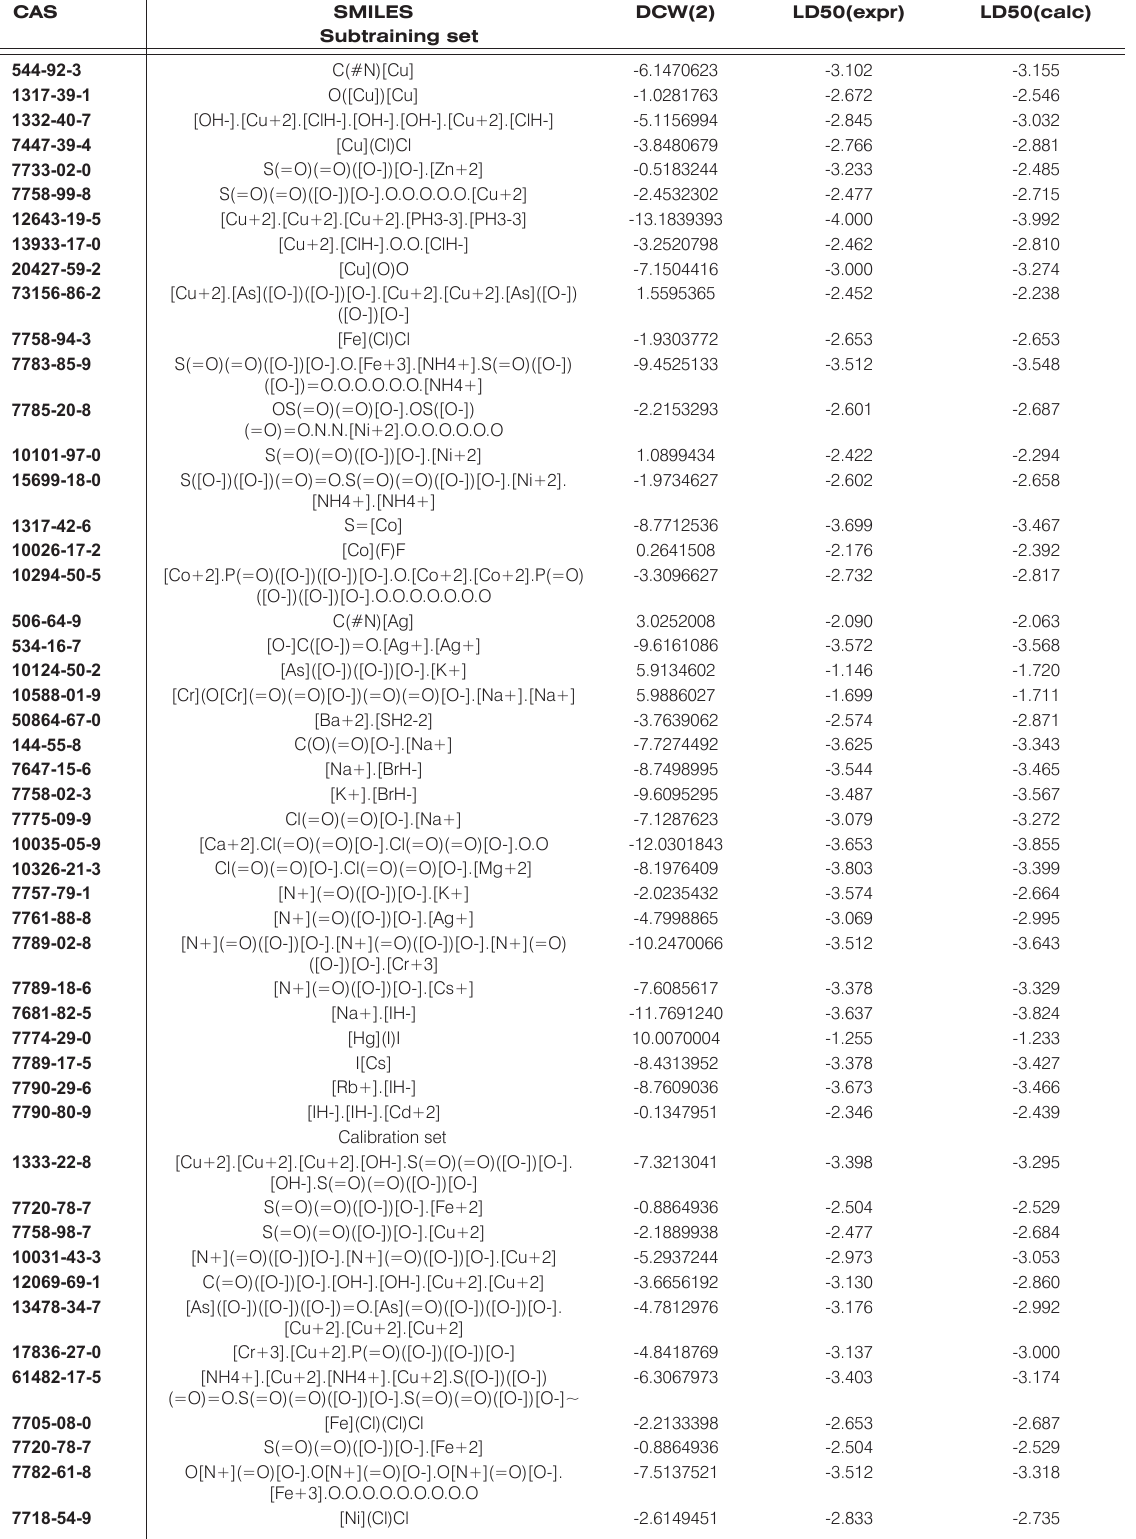
Table 4. The -pLD50 experimental values calculated with Eq.